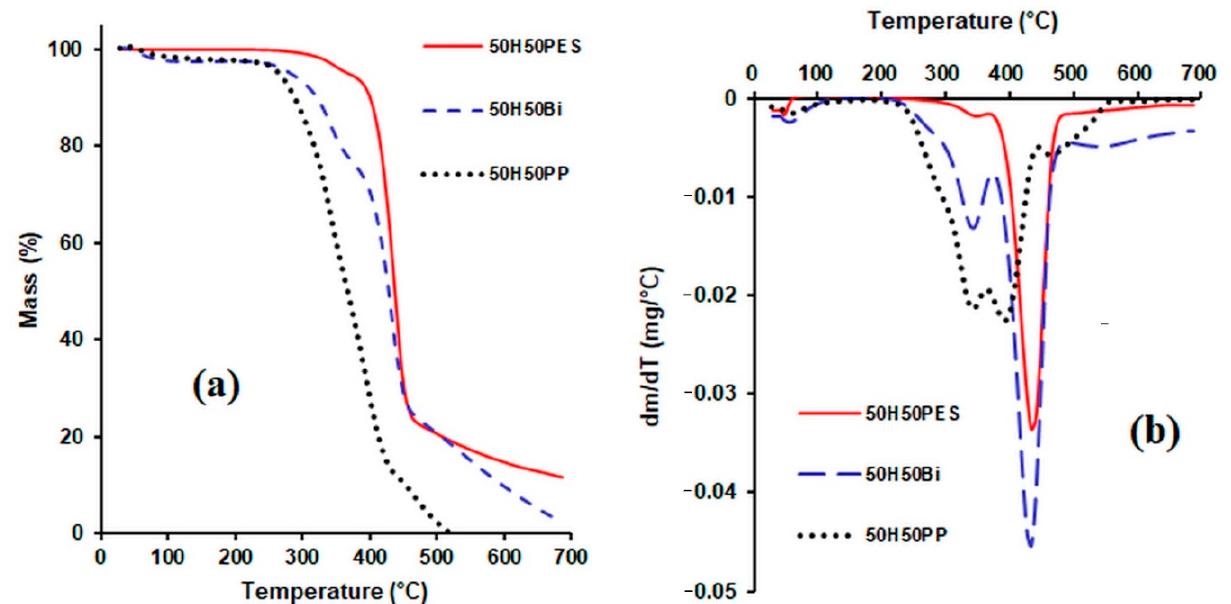
Figure 6. TG curves ( a ) and DTG curves ( b ) for composite materials consisting of hemp fibres and various matrices.